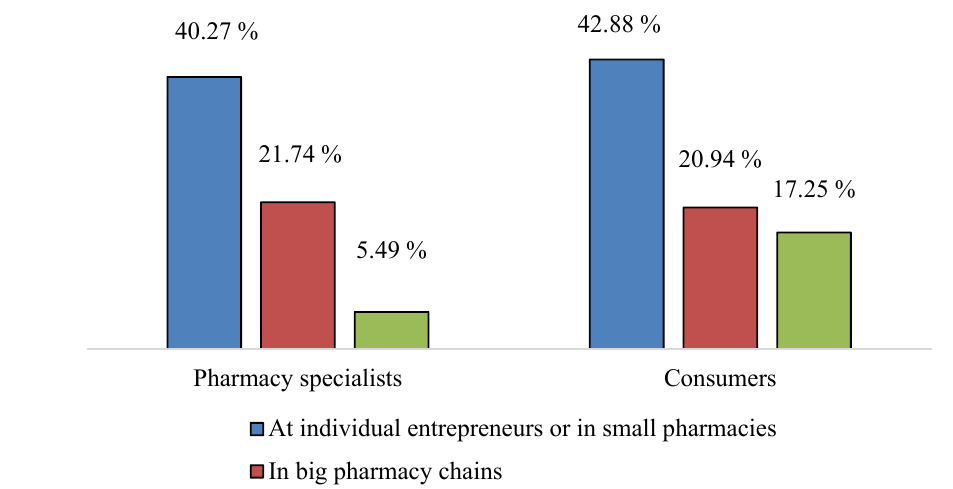
Fig. 5. Survey results on pharmacies that are at greater risk of purchasing counterfeit